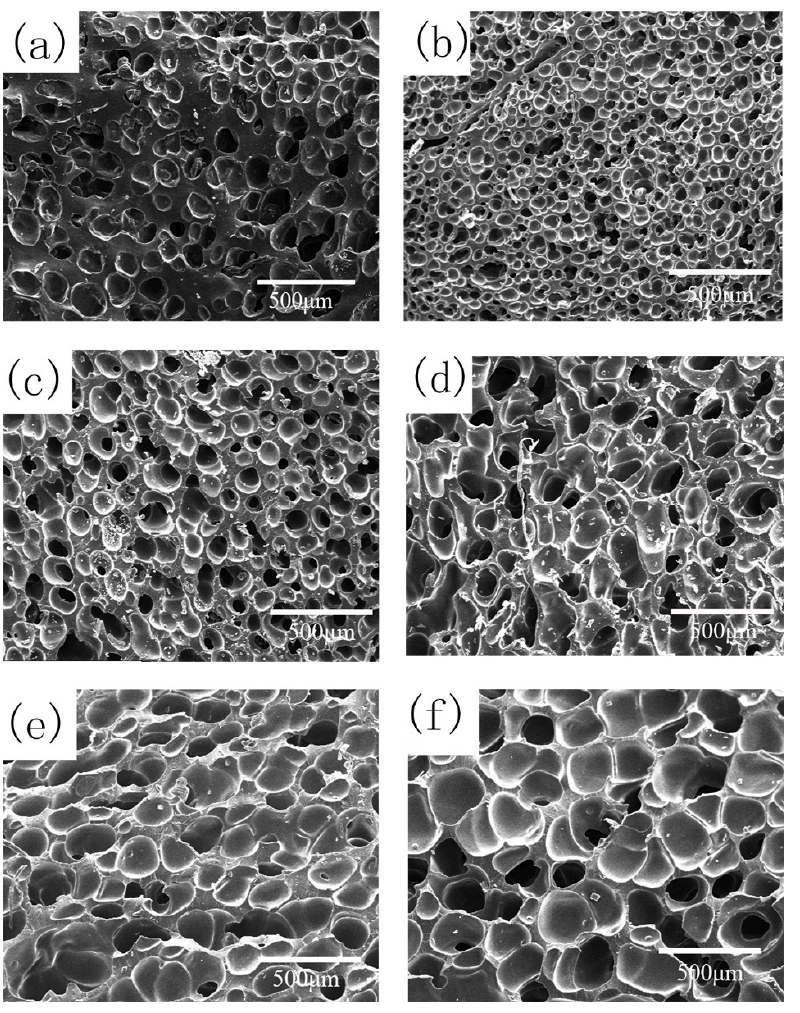
Figure 8. Cell morphology of foamed samples under different CO 2 saturation pressures: ( a ) 8 MPa; ( b ) 10 MPa; ( c ) 12 MPa; ( d ) 14 MPa; ( e ) 16 MPa; ( f ) 18 MPa. Table 4. Parameters of foamed samples at different CO 2 saturation pressures.